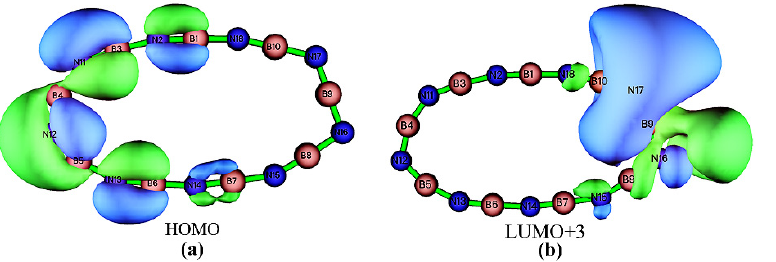
Figure 10. Isosurface maps of the ( a ) HOMO and ( b ) LUMO + 3 of B 9 N 9 corresponding to the application of EEF = 0.0365 a.u. The isovalue is chosen to be 0.03. The positive and negative orbital phases are distinguished by the two colors.